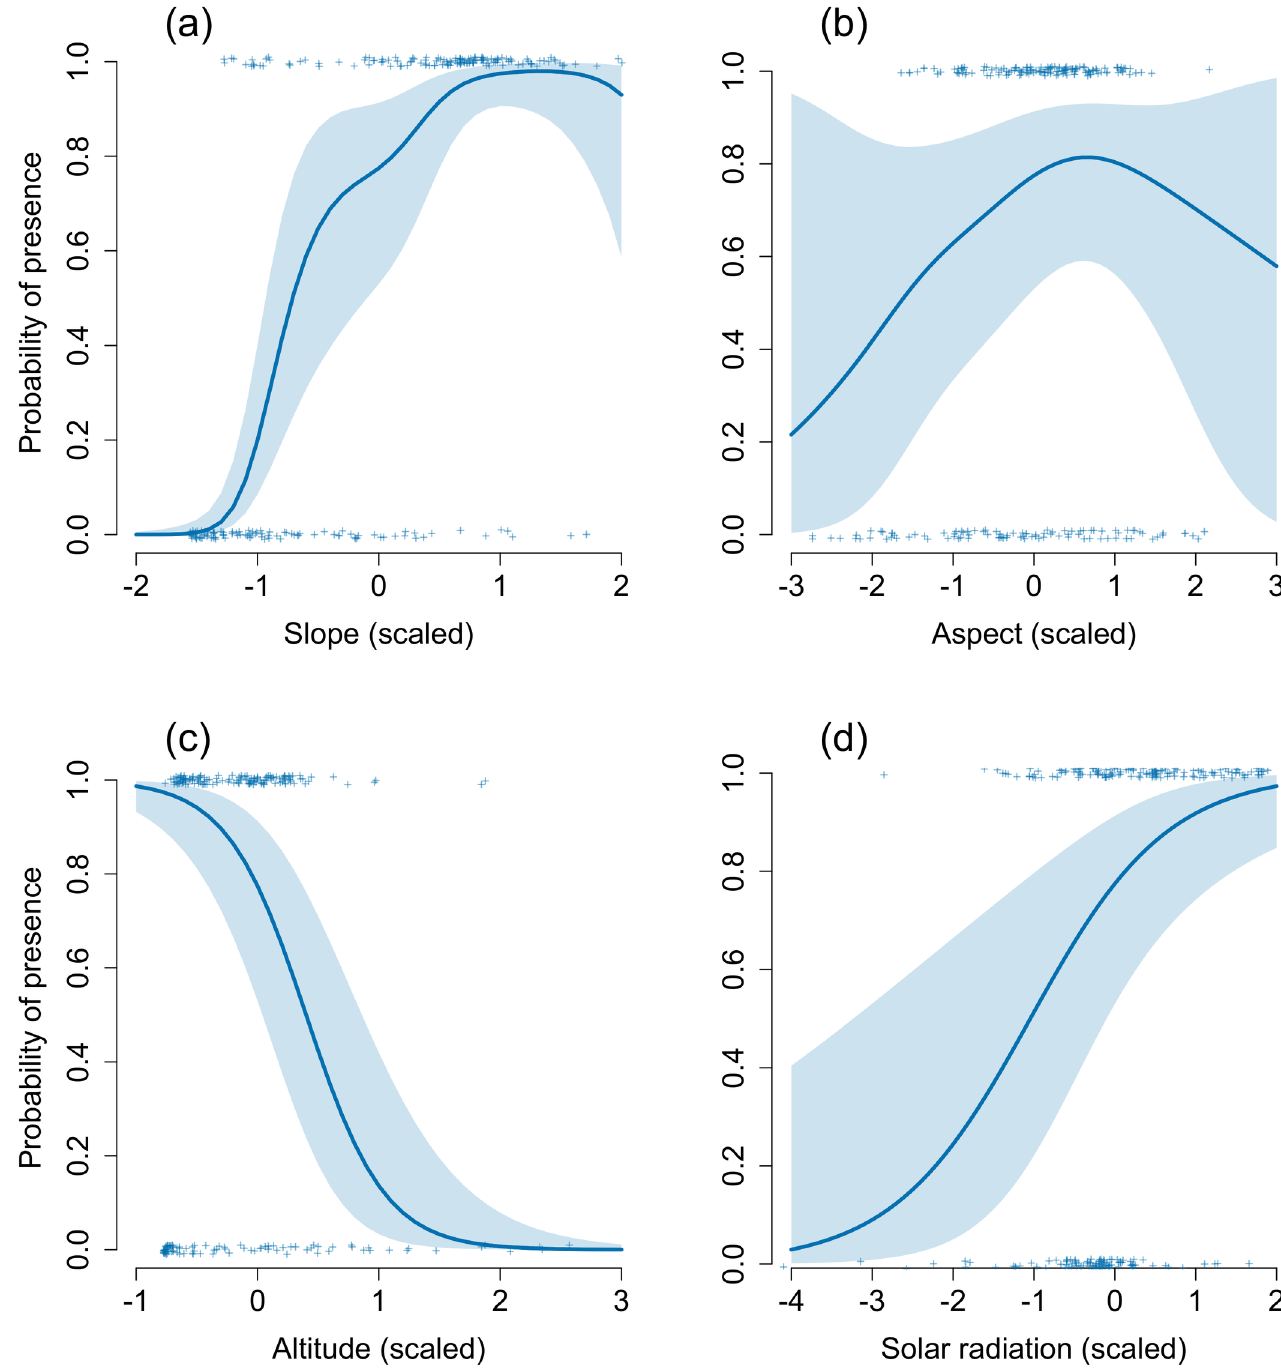
Fig 5. Probability of colony occurrence in relation to slope angle (A), aspect (B), altitude (C) and solar radiation (D). A and B are estimated smoothers, C and D–linear relationships on the logit scale. Bold line–estimated relationships, dashed lines–their 95% confidence intervals, crosses–data (0 –polygons, 1 –